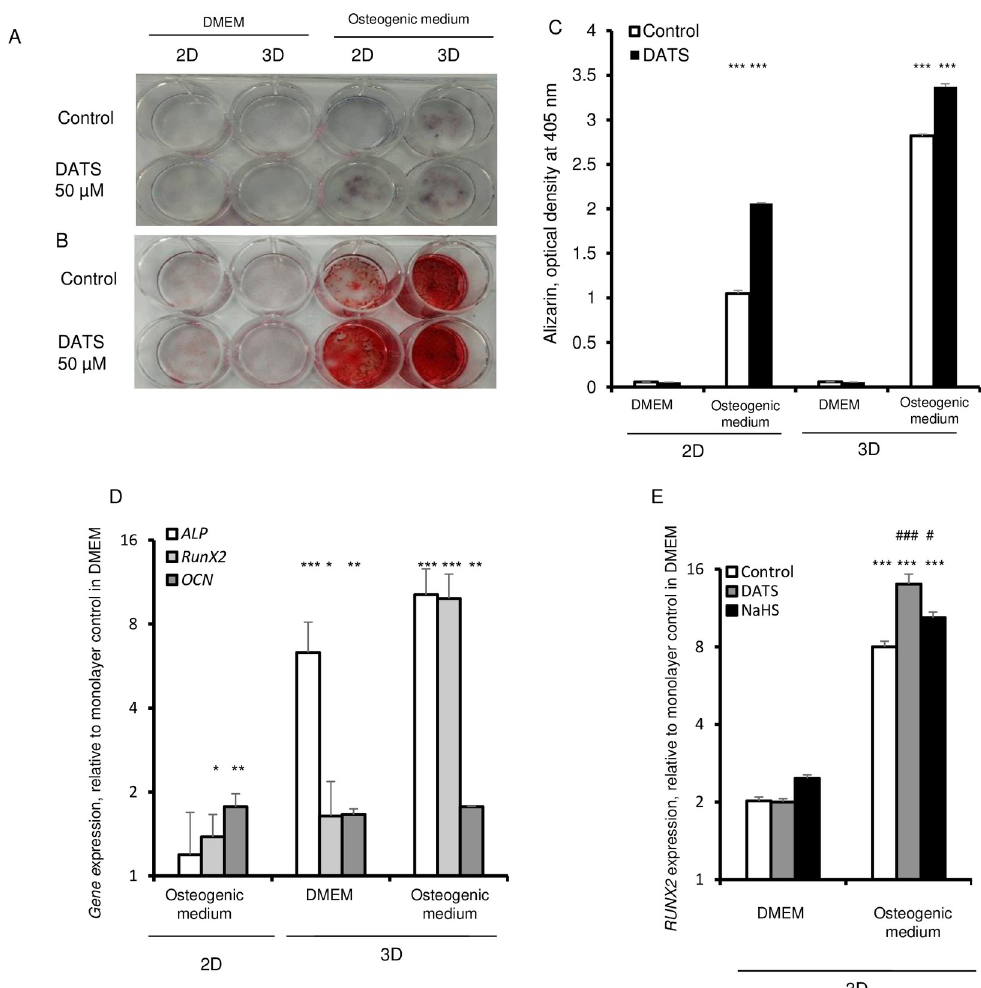
Red staining. B. Alkaline phosphatase staining. C. Densitometric analysis of Alizarin staining. D. mRNA expression levels of osteogenic markers such as alkaline phosphatase ( ALP ), osteocalcin ( OCN ) also referred to as bone γ -carboxyglutamic acid-containing protein or BGLAP, and RUNX2 , and expression of were evaluated in 2D and 3D cultures maintained in DMEM and culture condition allowing osteogenic differentiation. Expression levels were normalized to the expression level in monolayer (2D) cells cultured in DMEM. E. HDFs were cultured in 3D in the absence and presence of 50 μ M DATS or 100 μ M of NaHS for 6 days and then subjected to osteogenic differentiation. qPCR analysis of RUNX2 gene expression normalized to the expression level in 2D cultured cells. Statistical significance is shown as � (p � 0.05), �� (p � 0.005), and ��� (p � 0.0005) in 3D as compared to 2D cultured